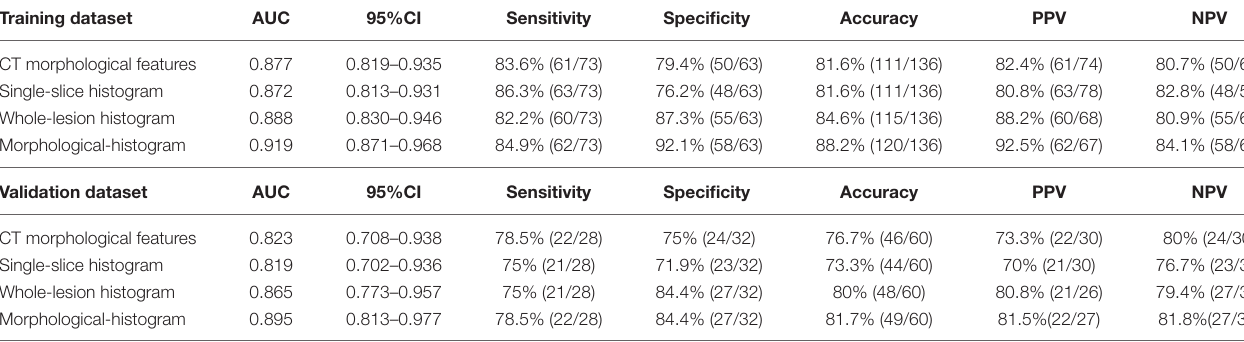
TABLE 4 | Accuracy and predictive value between those models.